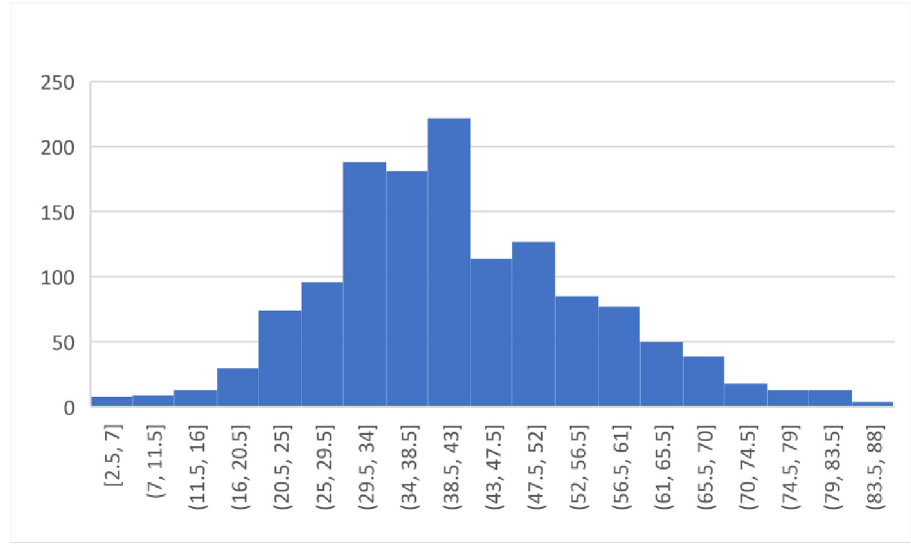
Fig 1. Age distribution of the